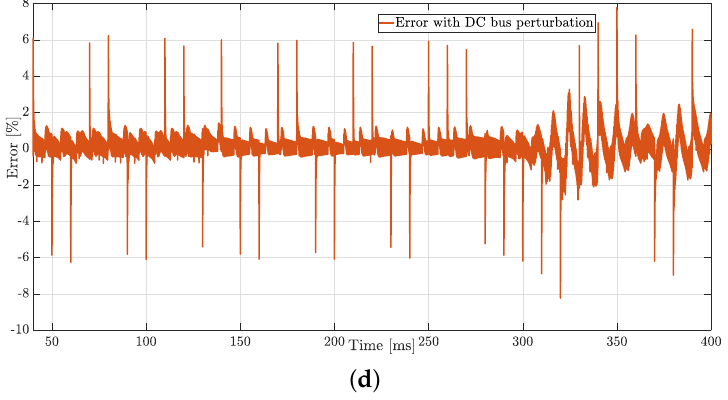
Figure 19. Performance measurements of the DAB converter and MPPT P & O . ( a ) Performance of the DAB converter; ( b ) MPPT efficiency; ( c ) Error of the control system without DC bus perturbation; ( d ) Error of the control system with DC bus